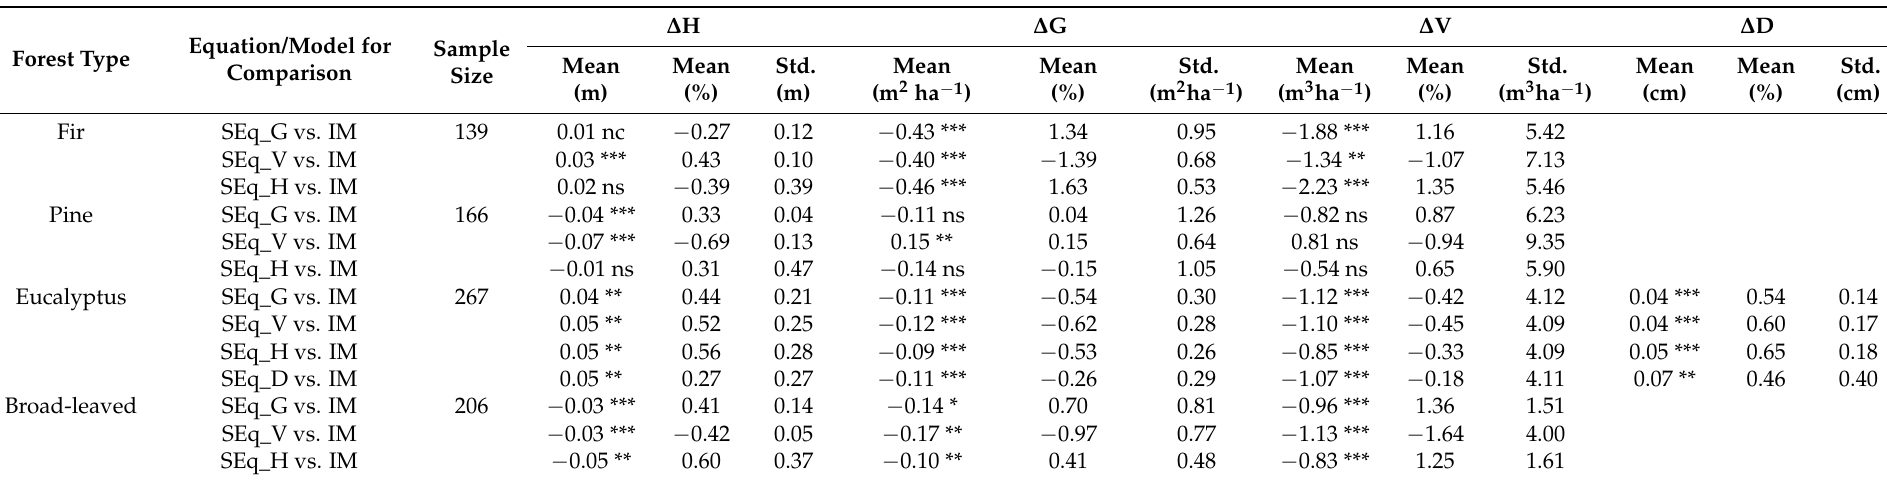
Table 5. Results of paired t -test of the mean stand attribute estimates for various forest types between the simultaneous equations and independence model.